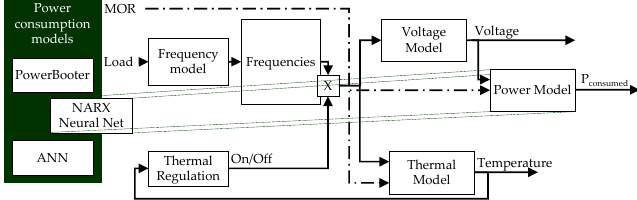
Figure 2. The incremental structure of the general model makes very simple to adapt it to changes in the structure and even exchange components at will. ANN: Artfical neural network. NARX: Nonlinear Autoregressive with eXogenous